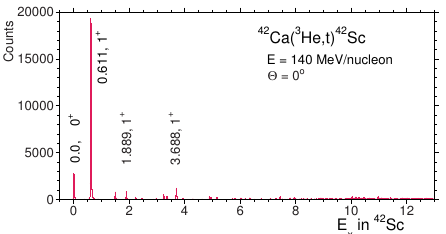
Figure 4. Gamow-Teller and M 1 transitions in A = 42, T z = 1, 0, -1 isobar nuclei 42 Ca, 42 Sc, and 42 Ti, where 42 Ca and 42 Ti 10 MeV, is ≈